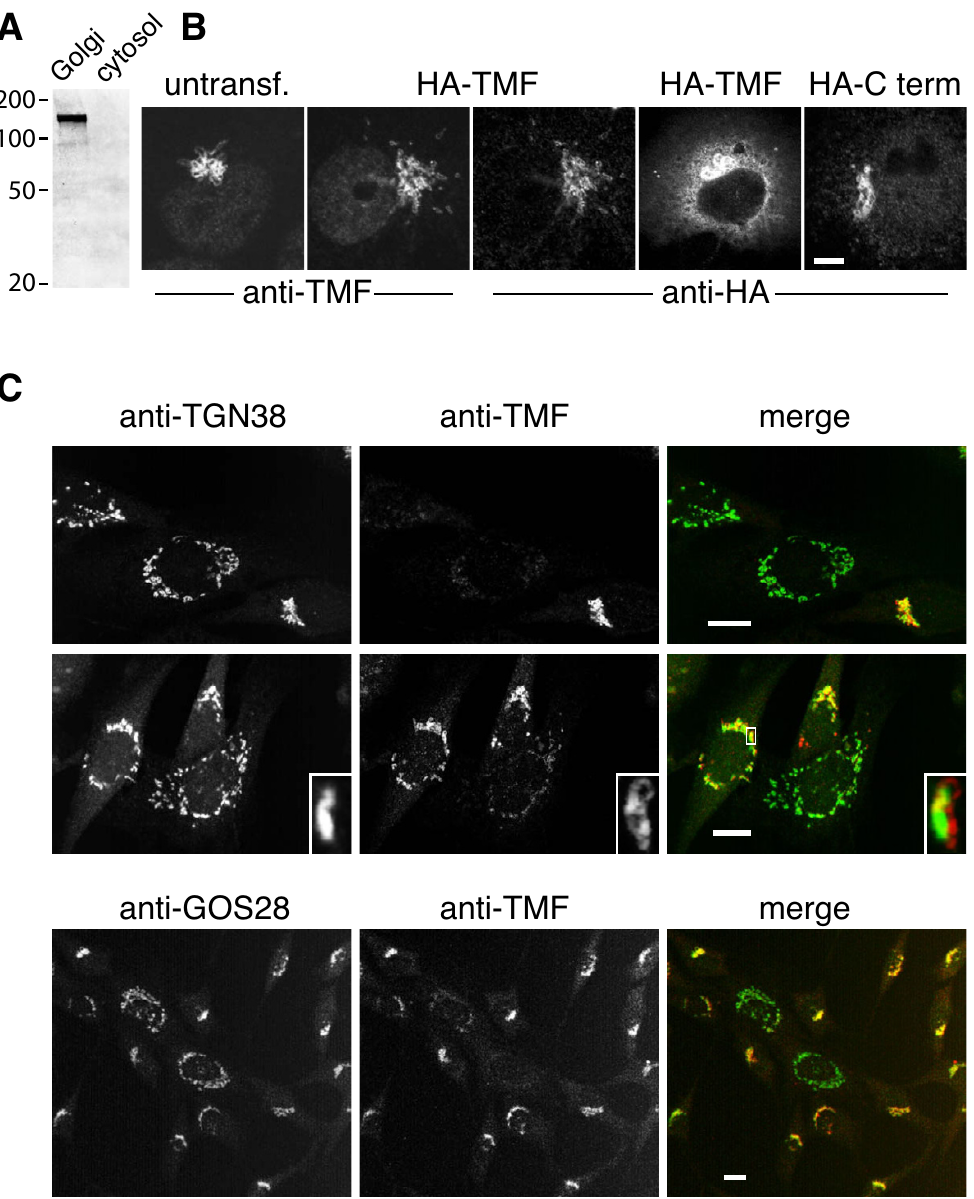
Figure 4 Location and function of TMF A. Immunoblot of Golgi and cytosol fractions with anti-TMF antibodies. The Golgi lane con- tained approximately 5 µ g total protein, the cytosol lane approximately 100 µ g protein. Marker positions (kDa) are indicated. B. Immunofluorescent images of COS cells showing endogenous TMF in an untransfected cell (untransf.), HA-tagged full-length protein expressed from a transfected plasmid (HA-TMF) and detected with both anti-HA and anti-TMF, as well as a cell expressing rather higher levels of HA-TMF (only the anti-HA image is shown; anti-TMF staining of this cell gave an identical pat- tern). The last panel shows the HA-tagged 310 C-terminal residues of HA (HA-C term) expressed similarly and detected with anti-HA. Bar is 10 µ m. C. Rat NRK cells transfected with RNAi and stained for TMF and either TGN38 or GOS28 as indicated. Note that TMF-depleted cells (green in the merged images) have more dispersed Golgi than the other cells. The insets in some panels show an enlarged region of the Golgi, boxed in the merged image. Bars are 10 µ